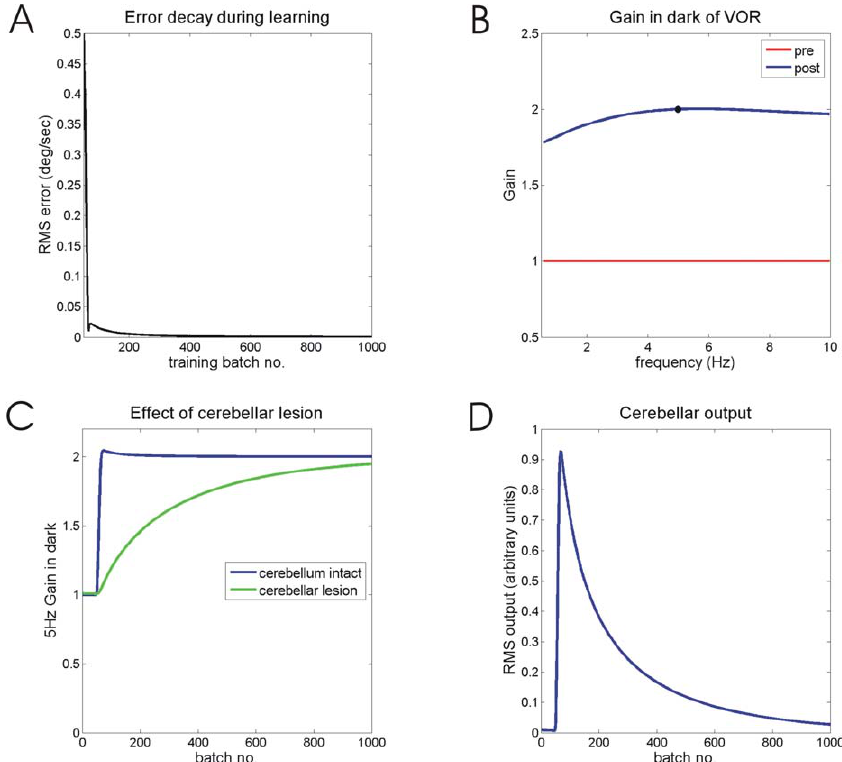
Figure 8. VOR Calibration with a Second Site of Plasticity in the Brainstem at 5Hz Training Frequency (A) Learning as measured by retinal-slip error. (B) Generalization of gain to frequencies other than that used in training. Graph format chosen to resemble that of Figure 7 of Raymond and Lisberger [25]. Black disc on ‘‘ post ’’ curve indicates training frequency. (C) Gain of system as training proceeds, with or without the simulated cerebellum. The effect of cerebellar inactivation becomes smaller with longer training. (D) Output of simulated cerebellum as training proceeds. An initial fast rise from a pre-training value of 0 is succeeded by a slower fall, eventually back to 0.